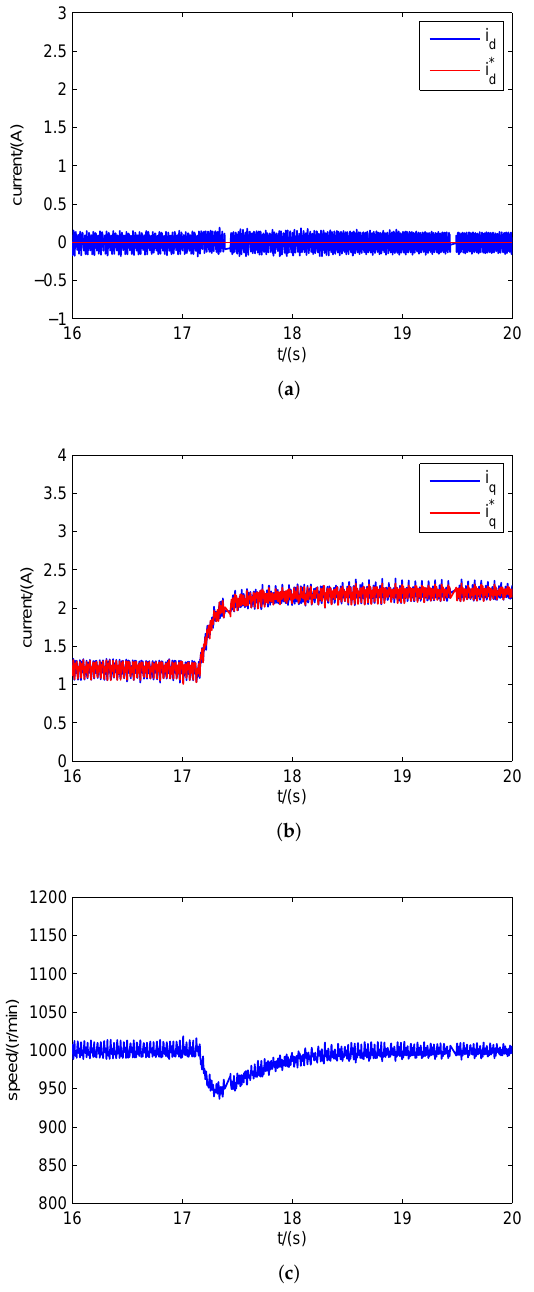
Figure 13. Experimental results with load disturbance: ( a ) d-axes current, ( b ) q-axes current, and ( c ) speed